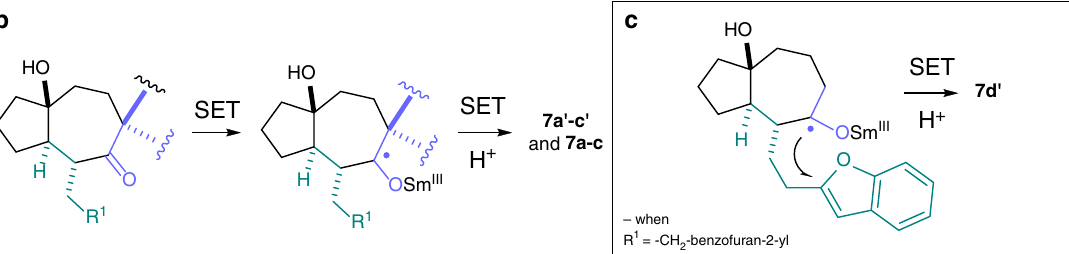
Fig. 3 Folding radical cascades following extended SET pathways. Samarium(II) folding cascades involving an extended SET pathway from key radical intermediates V are shown. a Folding of the substrates 6a ’ – d ’ allowed access to diols 7a ’ – d ’ bearing up to fi ve new stereocentres. The use of malonate- derived substrates 6a – 6c allowed the synthesis of complex lactones 7a – 7c . b The formation of products involves SET reduction of the carbonyl and diastereoselective protonation to give diols 7a ’ – c ’ . In the case of products 7a – c , the alcohol formed in the last step undergoes lactonisation. c The formation of product 7d ’ involves a dearomatising radical cyclisation of the samarium(II) ketyl radical intermediate formed upon ketone